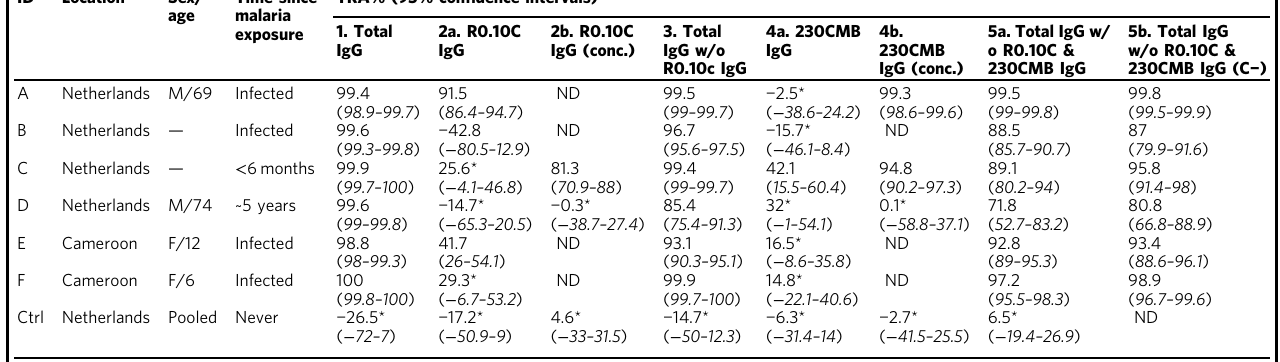
Table 2 Activity of af fi nity-puri fi ed antibodies against R0.10C (Pfs48/45) and 230CMB (Pfs230) from transmission-reducing sera